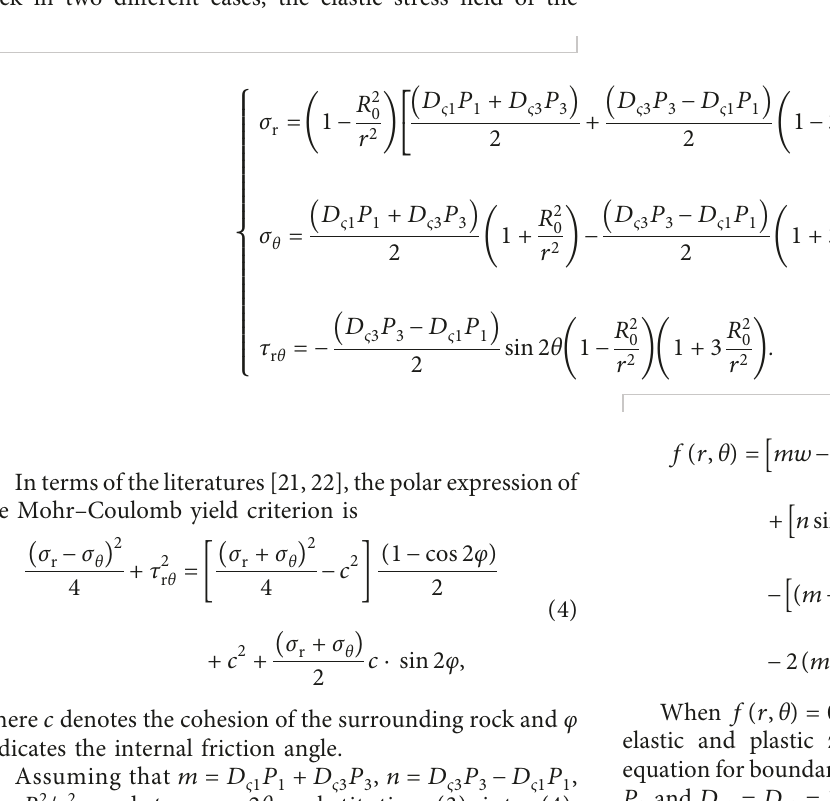
be obtained as follows: